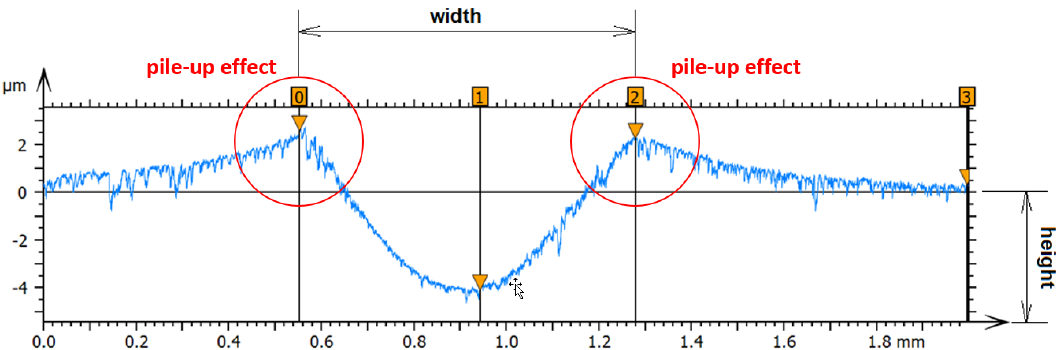
Figure 2. Cross-section profile performed on the monotonic residual track conducted at a maximum load of 400 N for the specimen with 10% of pre-existing